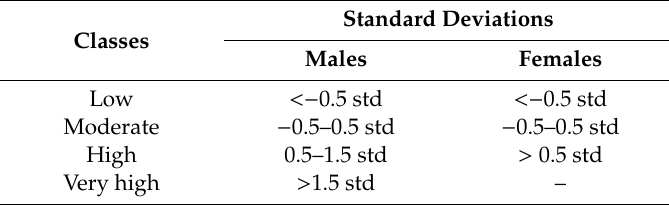
Table 1. The standard deviation classification method for the gender-specific values of